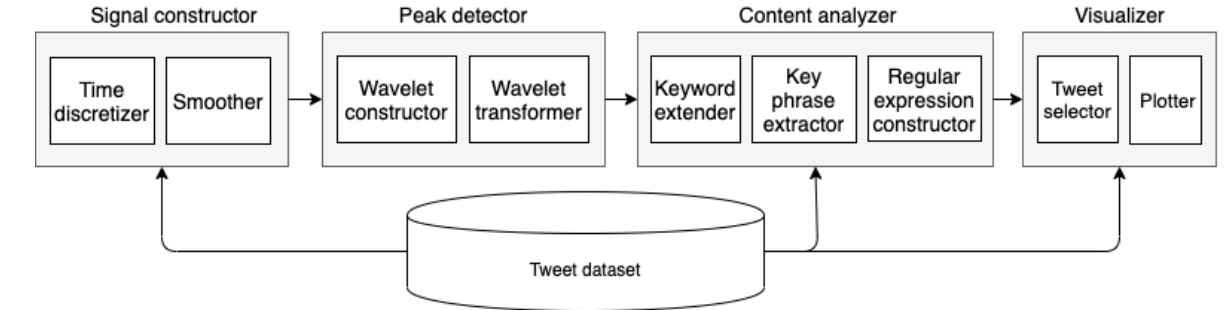
Figure 1. EventPeriscope analytical